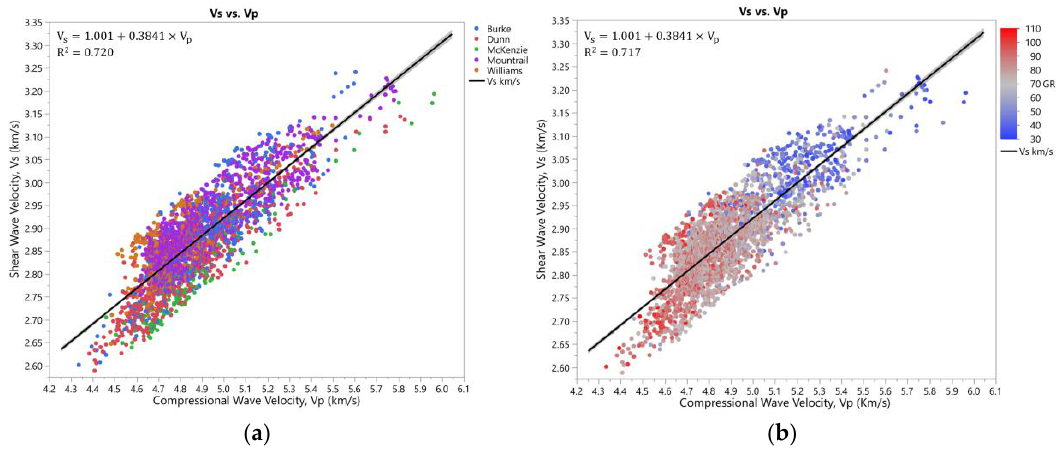
Figure 14. ( a ) Shear wave velocity versus compressional wave velocity for the Middle Bakken Formation. ( b ) Shear wave velocity versus compressional wave velocity with respect to gamma ray for the Middle Bakken Formation. Energies 2018 , 11 , x FOR PEER REVIEW